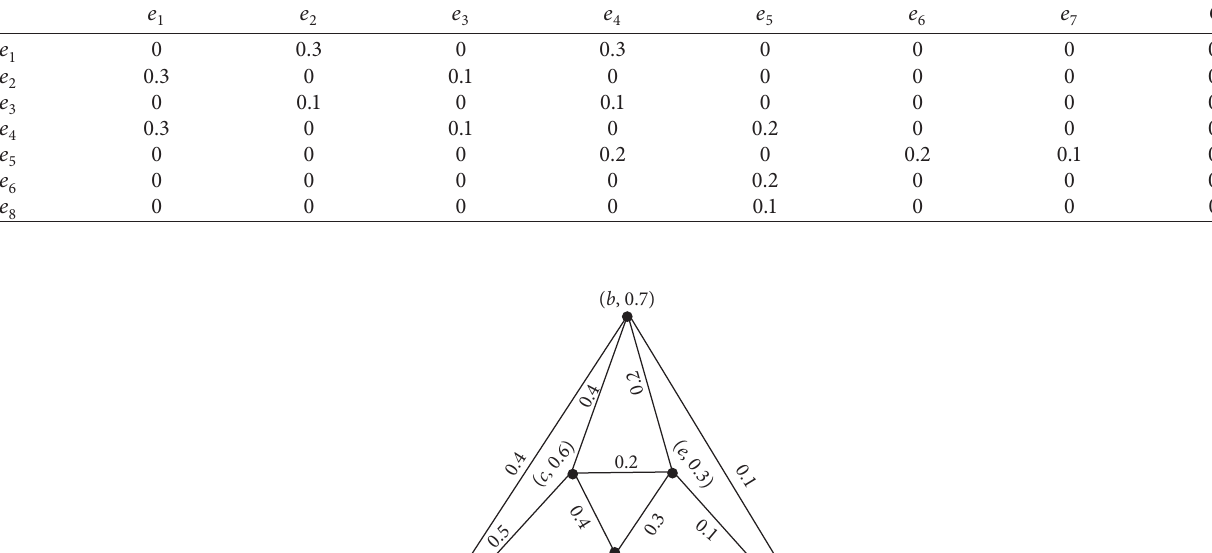
Table 3: The tabular representation of Z ∗ ( e